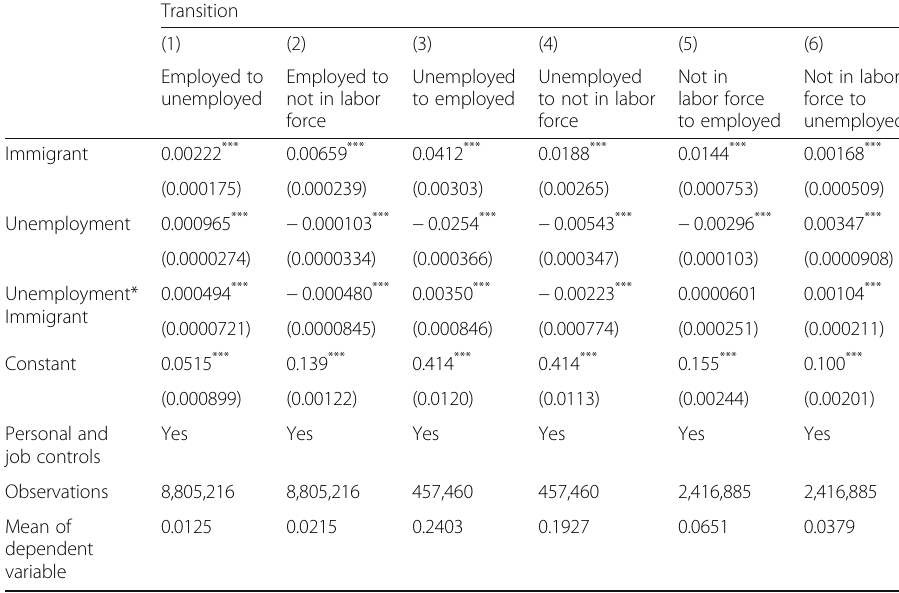
Table 6 Three-way transitions across all labor force states: matched CPS data, 1996 –